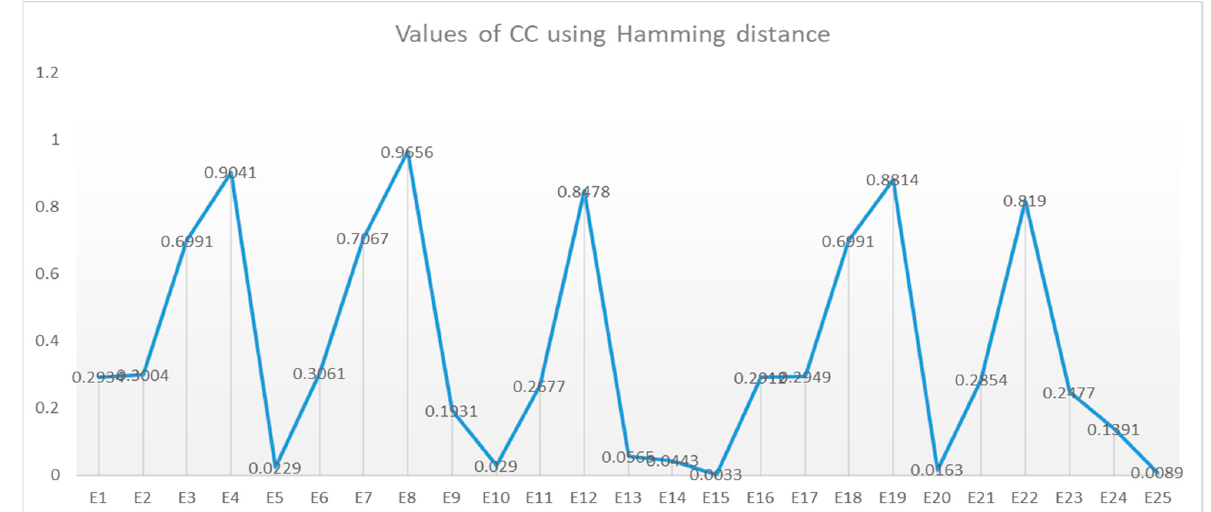
. Figure 2. Values of CC using newly proposed similarity measure. 4. Discussion To further validate the results, the results were compared with other methods, namely, the Hamming distance measure (Figure 3), the Euclidean distance measure (Figure 4), and the fuzzy simple additional weighting (fuzzy SAW) method [19] (Figure 5). It was shown that the Hamming distance method and fuzzy SAW ranked the top five results identically to our proposed method (